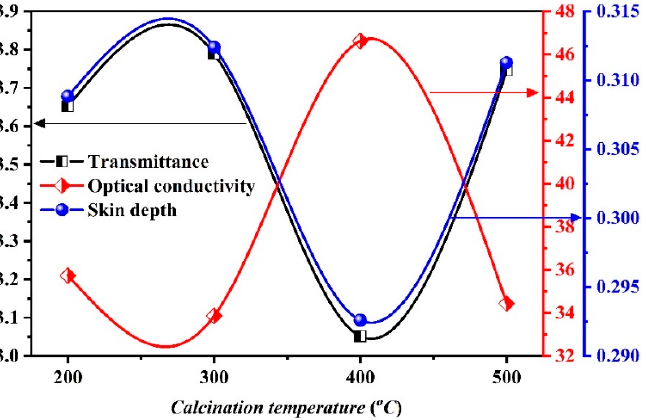
Figure 6. Variation of transmittance, optical conductivity ( × 10 7 ), and skin depth at a wavelength of 385 nm as a function of calcination temperature.